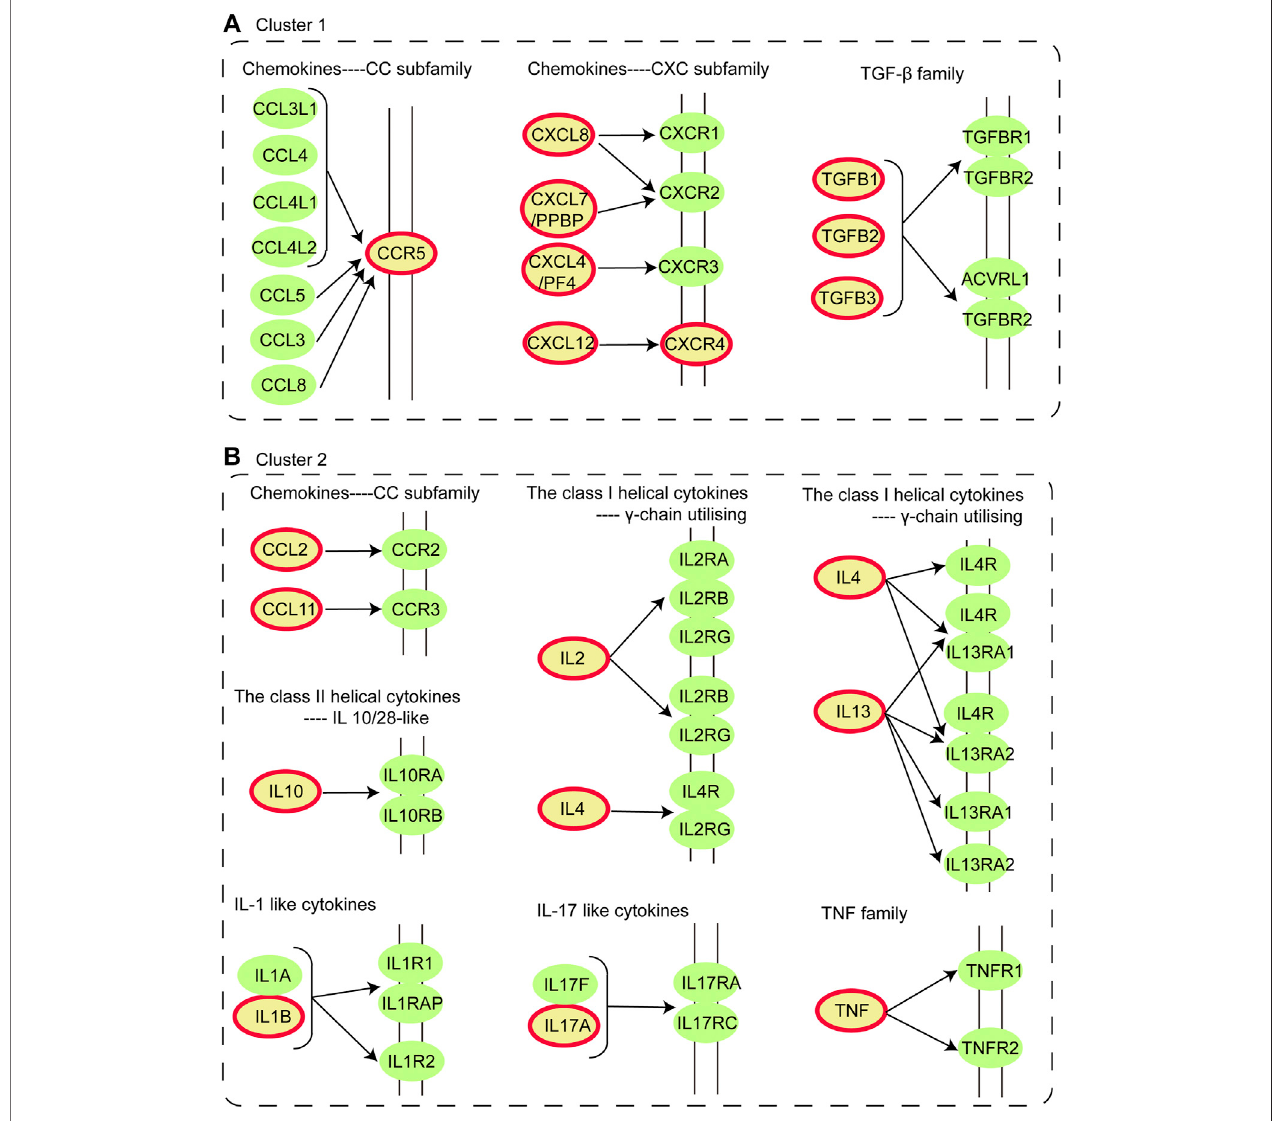
FIGURE 2 | Dissection of Cytokine-cytokine receptor interaction pathway. (A) Distribution of immune genes in Cluster 1 in Cytokine-cytokine receptor interaction pathway. (B) DistributionofimmunegenesinCluster2inCytokine-cytokinereceptorinteractionpathway.Thenodescoloredinyellowwitharedcircleareimmunegenes identi fi ed in Cluster 1 and